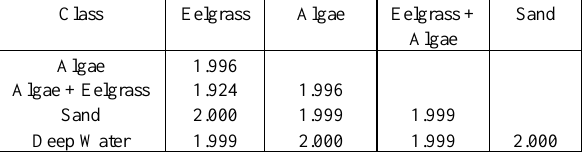
J-M Distances computed with all 11 bands from the Sentinel-2 image